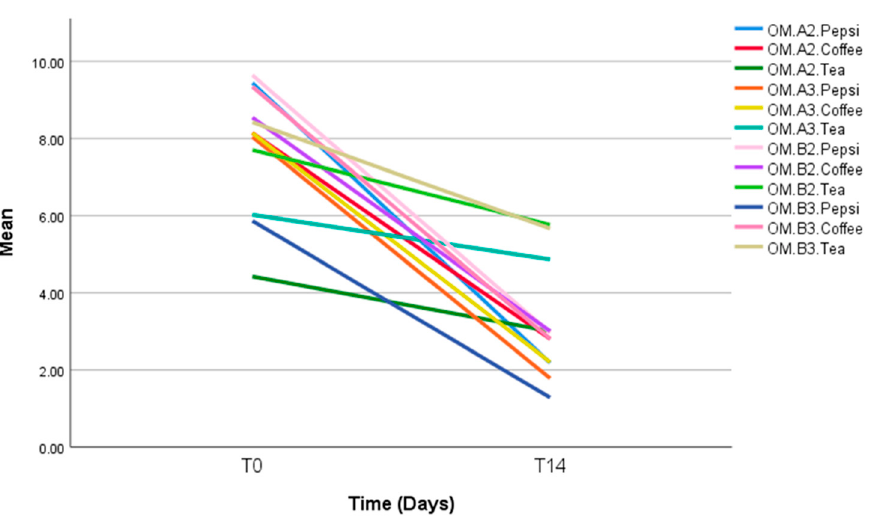
Figure 4. Graphical representation of mean changes in color ( ∆ E) value of Omnichroma composite from T0 (Day 0) to T14 (Day 14).